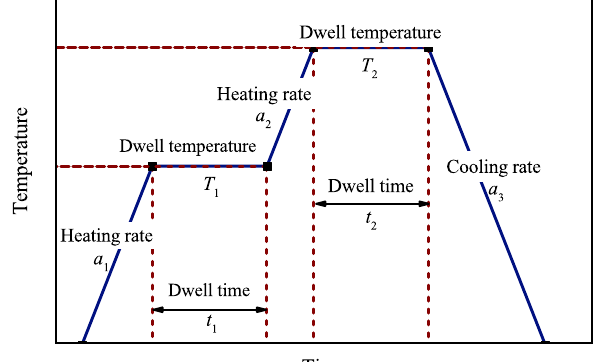
Figure 9. Two-dwell curing